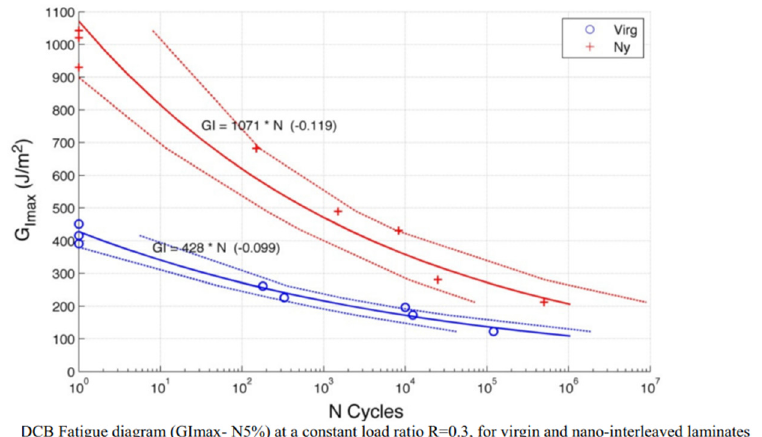
Figure 22. Strain energy release rate versus No. of cycles for nylon 66 nanofibre interleaved and virgin composite.